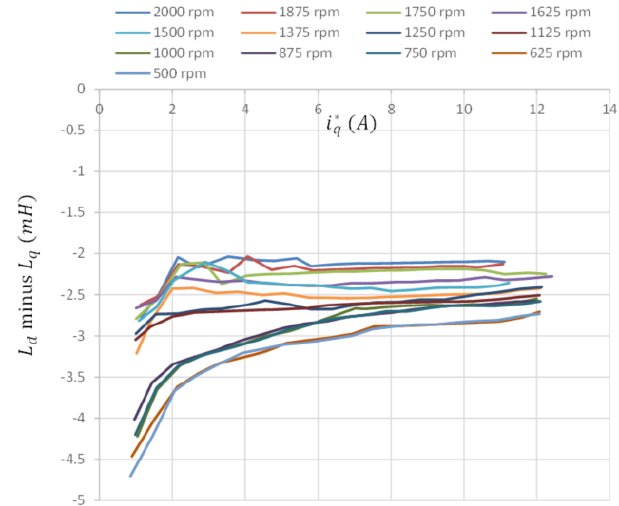
Figure 9. Data of dq -axis inductance